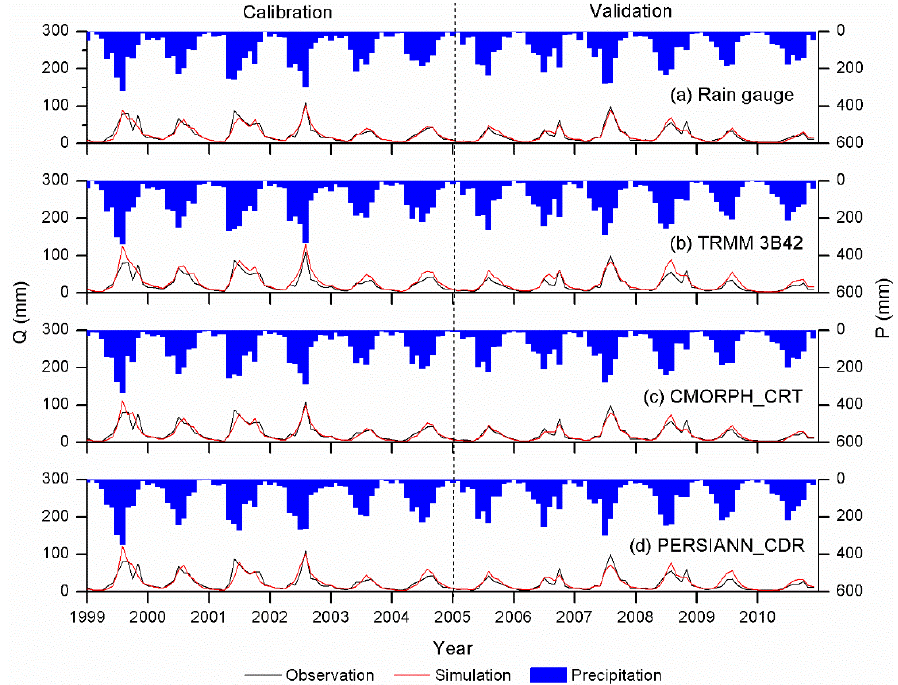
Figure 8. Simulated (red) and observed (black) monthly streamflow under Scenario I from: ( a ) rain gauge